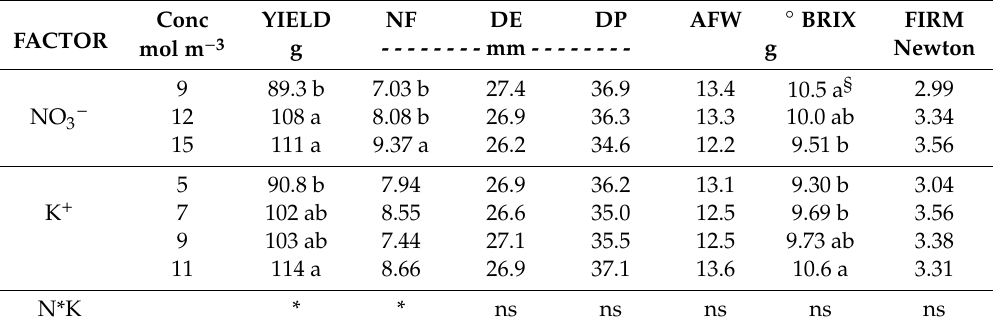
Table 1. Mean values for yield (YIELD), number of fruit (NF), equatorial and polar diameter (DE and DP, respectively), fruit weight (AFW), soluble solids ( ◦ Brix) and Firmness (FIRM) for the levels and interactions of N and K in the nutrient solution in strawberries under soilless